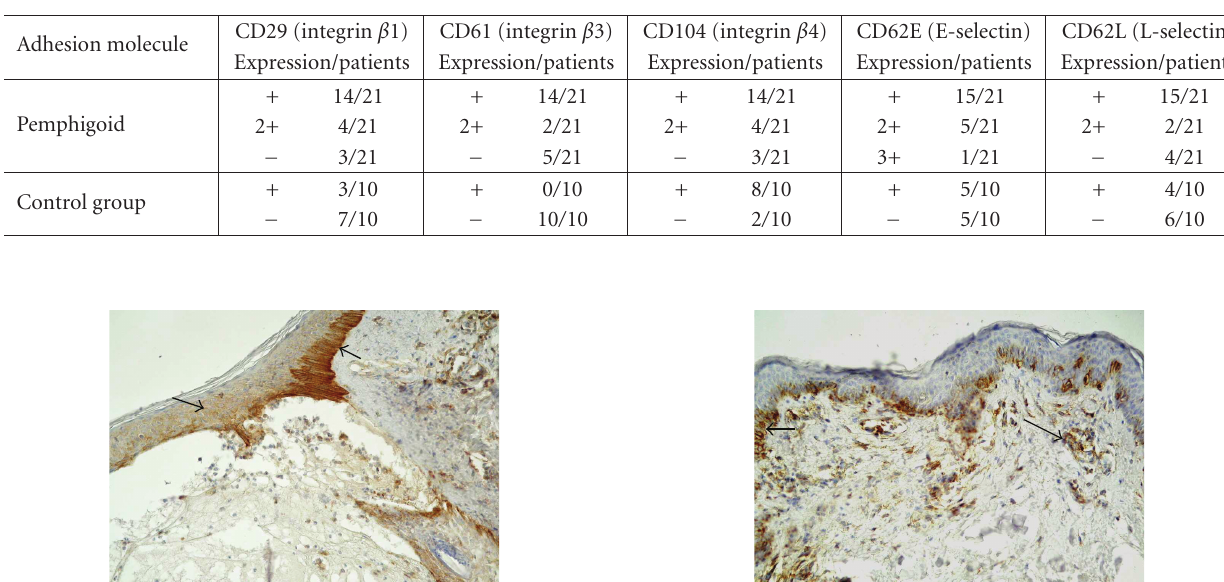
Table 1: Mean immunoexpression of CD29, CD61, CD104, CD62E, and CD62L in BP and control group.